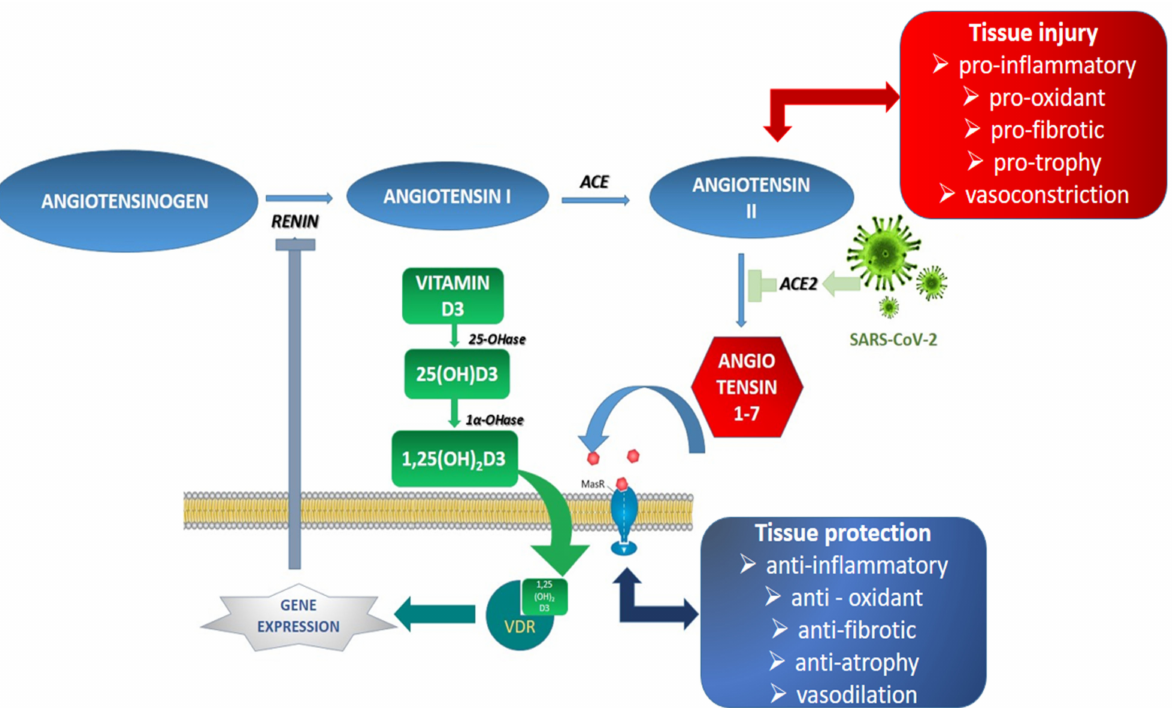
Figure 3. Renin–angiotensin system: SARS-CoV-2 infection and implication of vitamin D. In SARS-CoV-2 infection, virus attachment to the ACE2 receptors blocks angiotensin II conversion into angiotensin 1,7 and leads to tissue injury reactions. Vitamin D function cascade [vitamin D3 is produced in the skin under ultraviolet radiation exposure, 25(OH)D3—25-hydroxyvitamin D (calcifediol, ergocalciferol), 1,25[OH] 2 D3—1,25-dihydroxy vitamin D (calcitriol)] and vitamin D receptor (VDR) are implicated in the suppression of the renin gene expression, thereby inhibiting the renin-angiotensin system. Renin catalyses the conversion of angiotensinogen to angiotensin I, which is further converted to angiotensin II. Normally, angiotensin II turns into angiotensin 1–7—the tissue protector via MasR